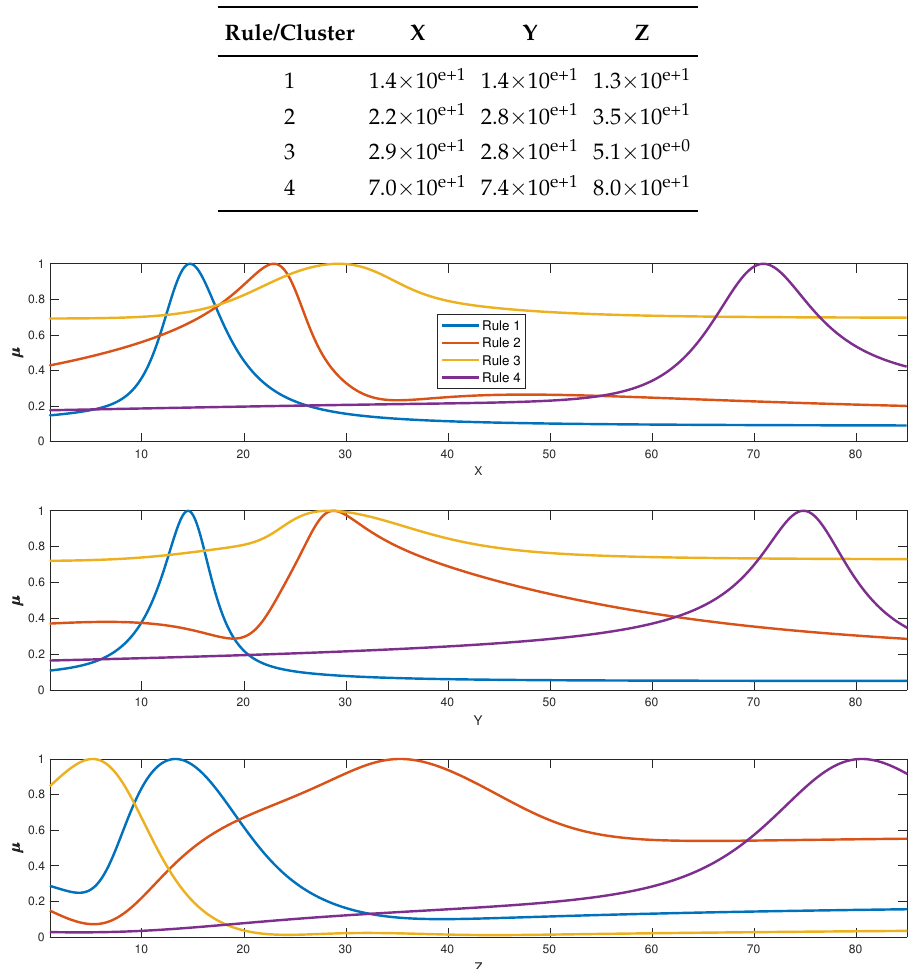
Figure 7. Membership functions for the clusters identified from the CIEXYZ training dataset. Fuzzy membership degree of each data to each fuzzy set is denoted by µ for simplicity (y